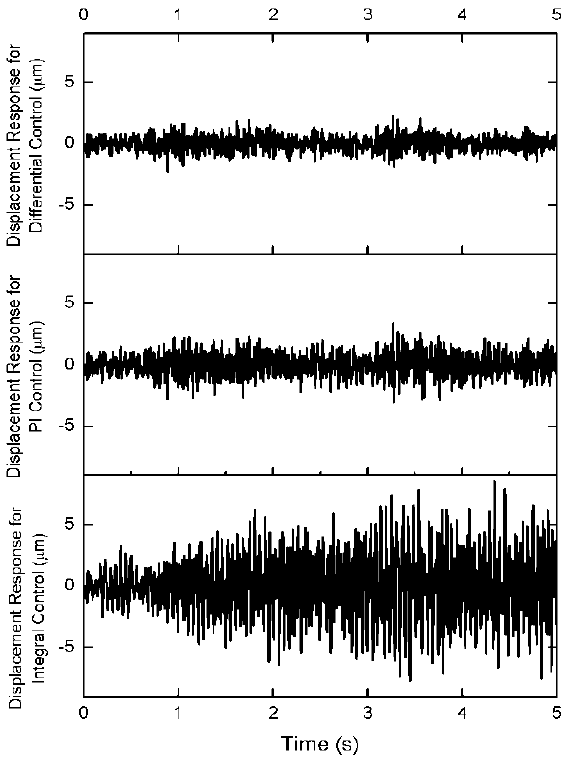
Figure 6. Displacement responses on the top of arm